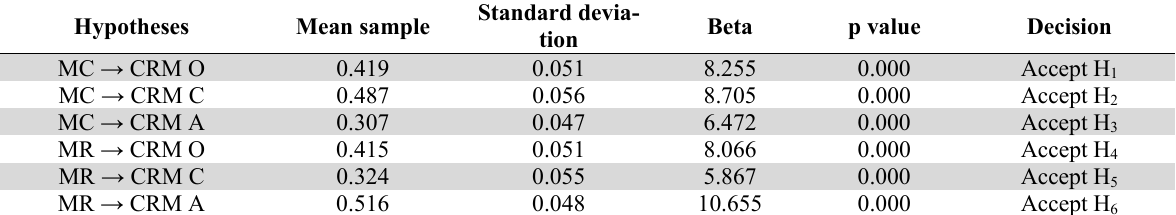
Results of the model structure